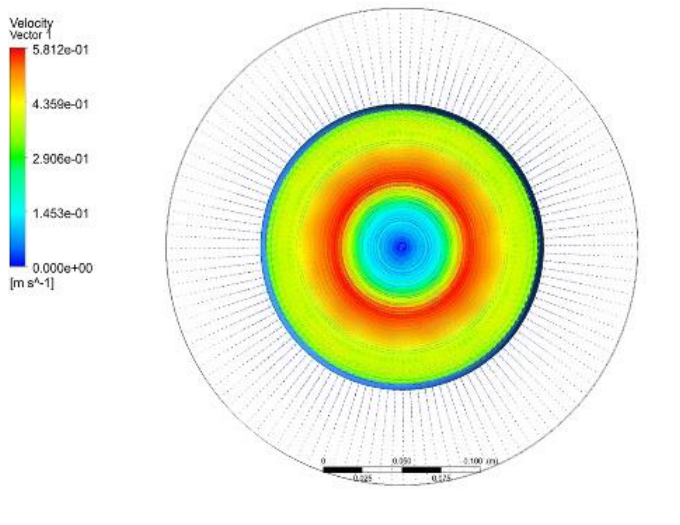
Figure 19. ( δ = 0.6, r = 100).